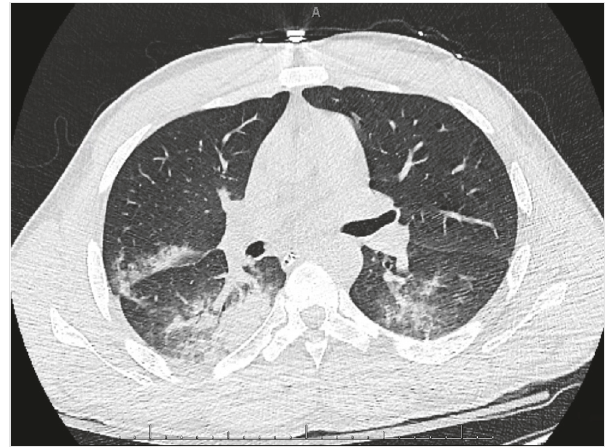
Figure 2: Computerized tomography (CT) of the chest 36 hours after admission, showing bilateral parenchymal